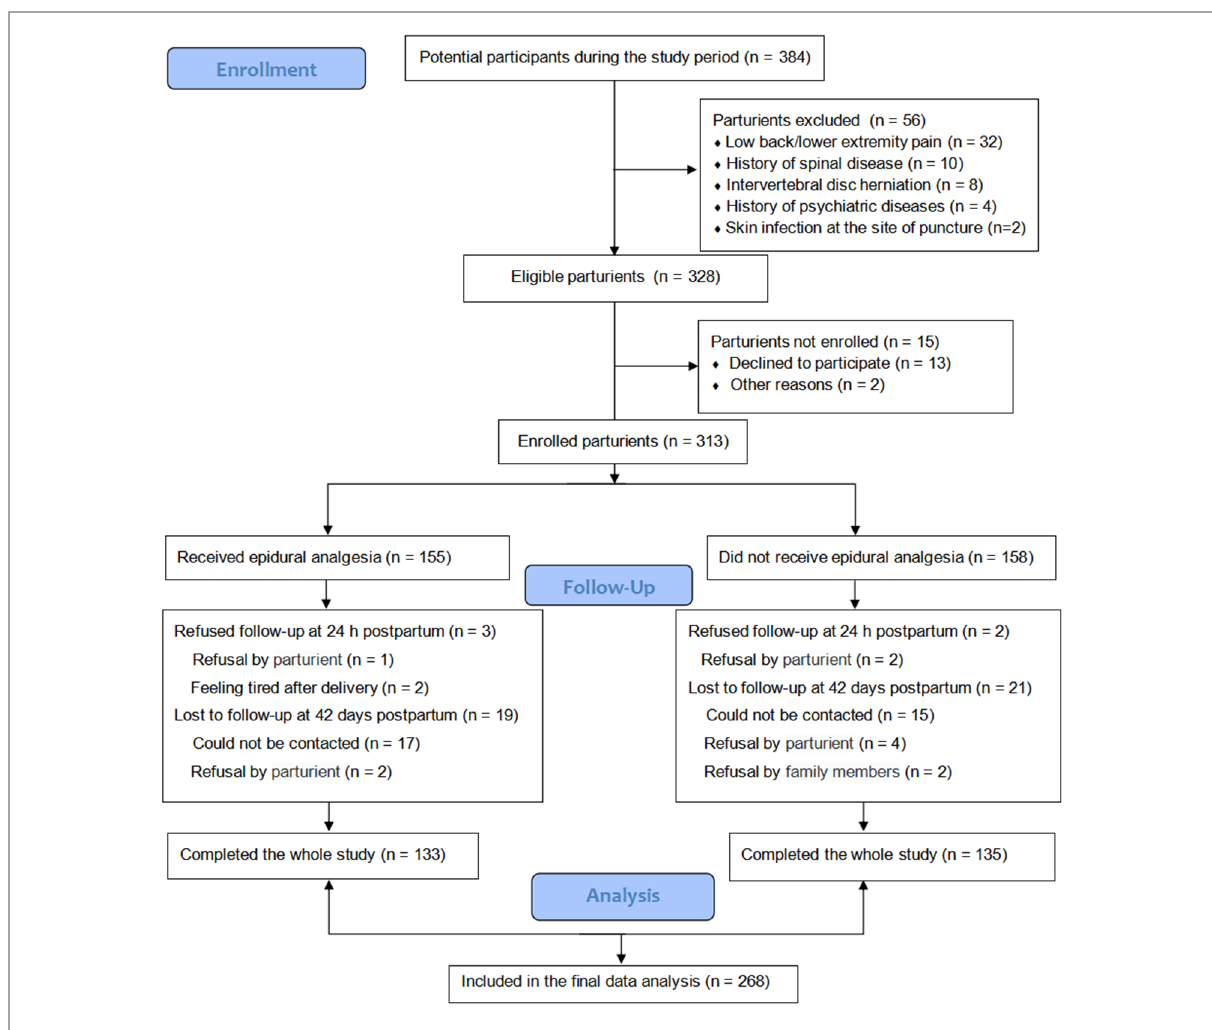
FIGURE 1 Flow chart of patient